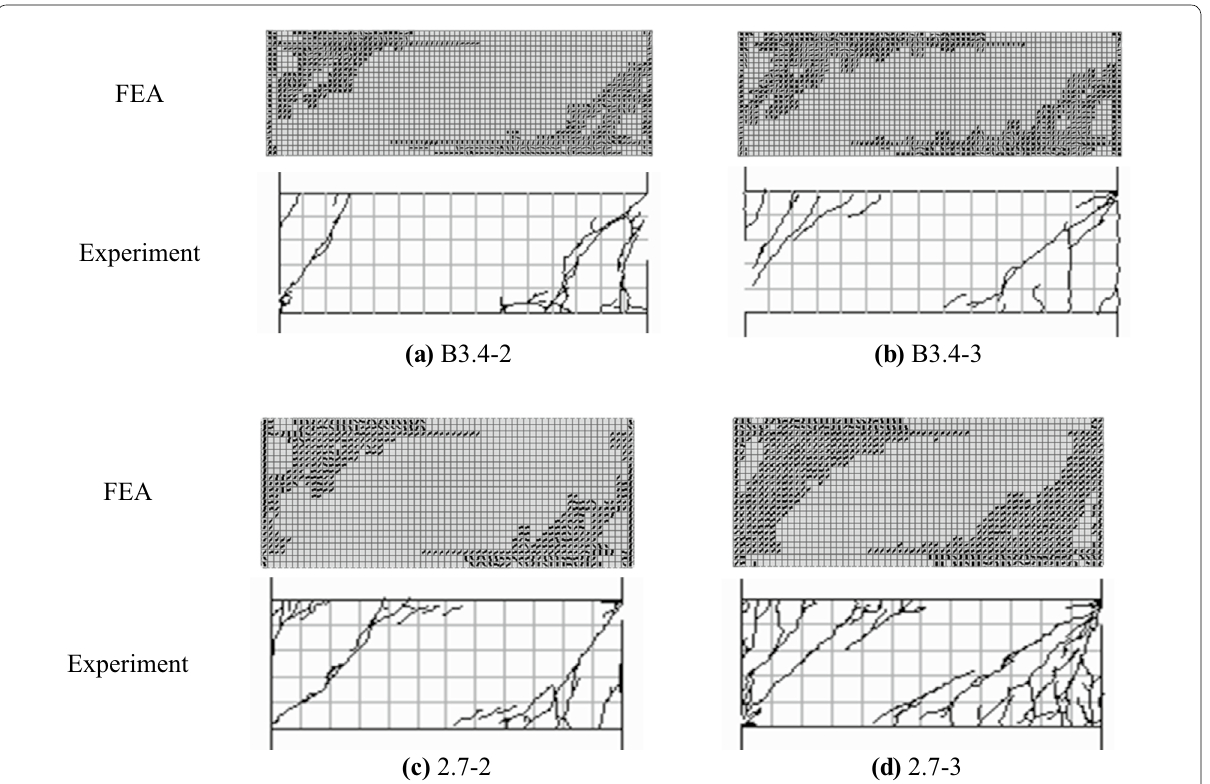
Fig. 9 Crack patterns prediction using finite element analysis (FEA) compared to experiment.